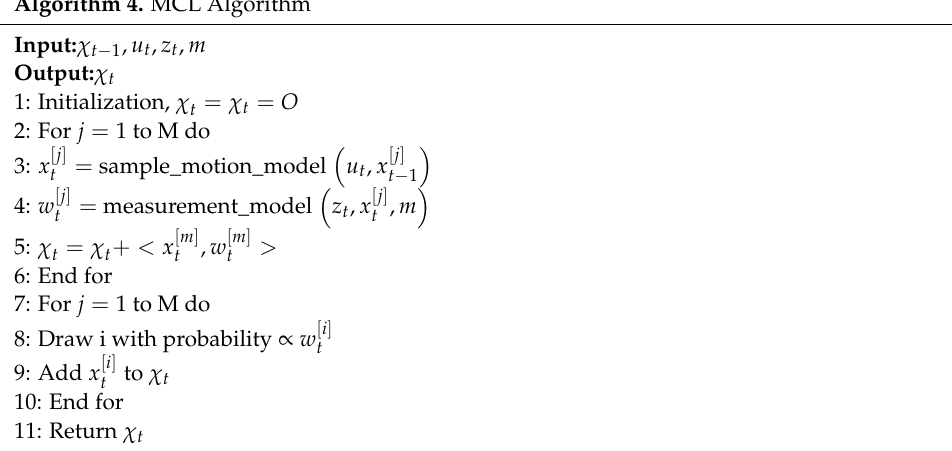
Algorithm 4. MCL